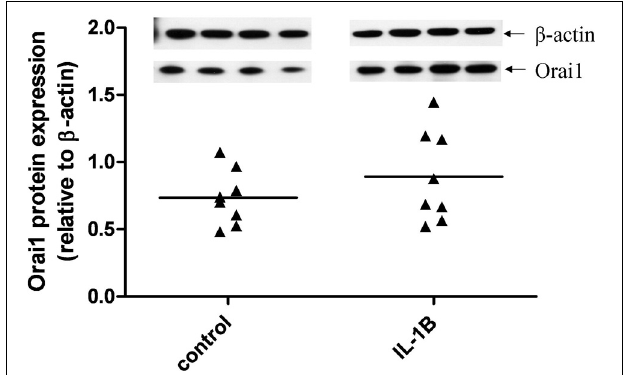
FIGURE 6 | Effect of IL-1 β on Orai1 protein expression in primary hUSMCs. Serum-deprived primary hUSMCs were incubated in the presence or absence of 10ng/ml IL-1 β for 24h. Whole cell lysates were assessed for Orai1 protein expression. Data are expressed relative to b-actin protein expression, (cells from n = 8